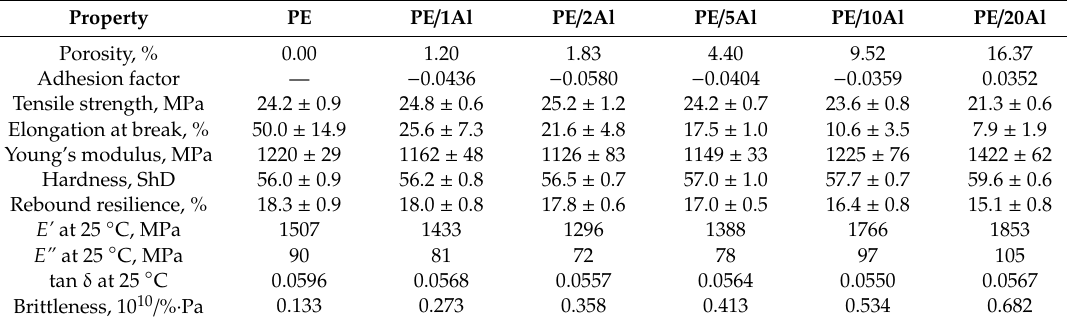
Table 1. Physico-mechanical characteristics of prepared